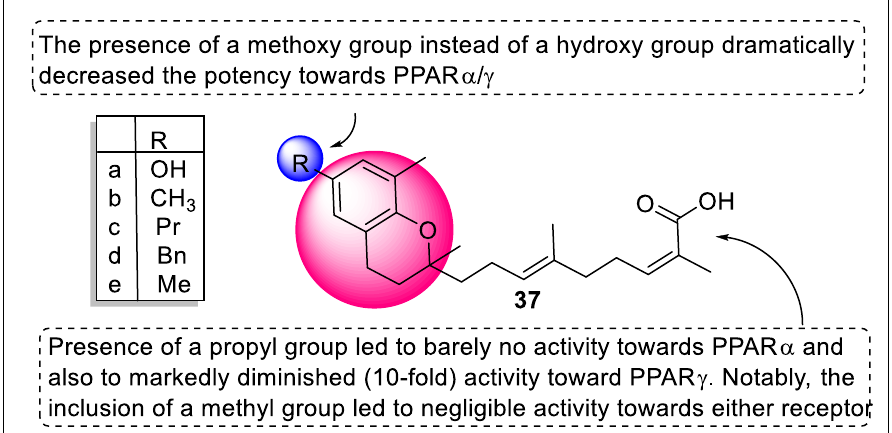
Figure 41. Structural activity relationship of benzopyran hybrids ( 37 ) as potent PPAR ligands. 5,7-dihydroxy-8-(1-(4-hydroxy-3-methoxyphenyl)allyl)-2-phenyl-4 H -chromen-4-one